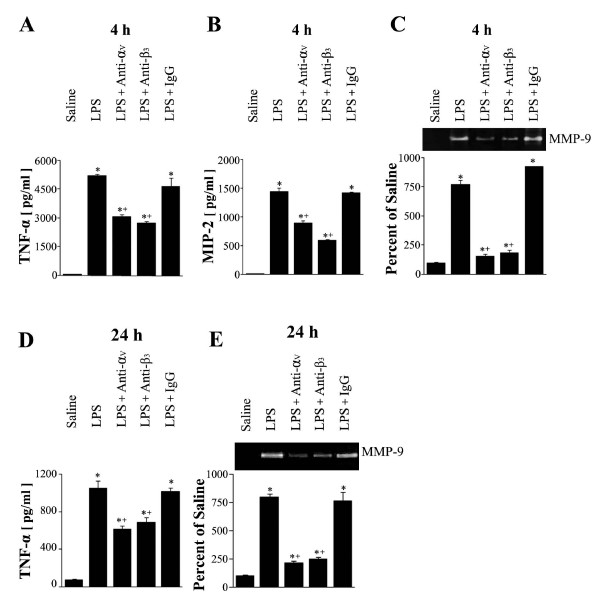
Effects of anti-αv or anti-β3 mAb on LPS-induced TNF-α and MIP-2 productions, and on MMP-9 activity. Where indicated, mice were administered anti-αv, anti-β3, or IgG (5 mg/kg, i.p.) once 1 h before LPS treatment and sacrificed 4 h post-LPS. Mice were also administered these mAbs (5 mg/kg, i.p.) once 2 h after LPS and sacrificed 24 h post-LPS. TNF-α(A, D) andMIP-2 (B) productions, and MMP-9 activity (C, E) in BAL fluid. Values represent means ± SEM of 5 mice per group. *Significantly different from saline treated controls, p < 0.05;+significantly different from animals treated with LPS only, p < 0.05.